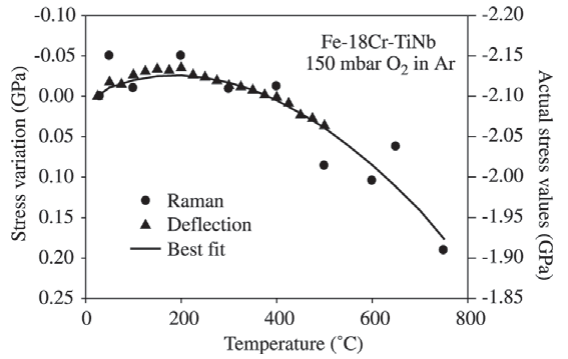
Figure 4. Stress evolution in oxide scales on Fe-18Cr-TiNb dur- ing cooling to room temperature.